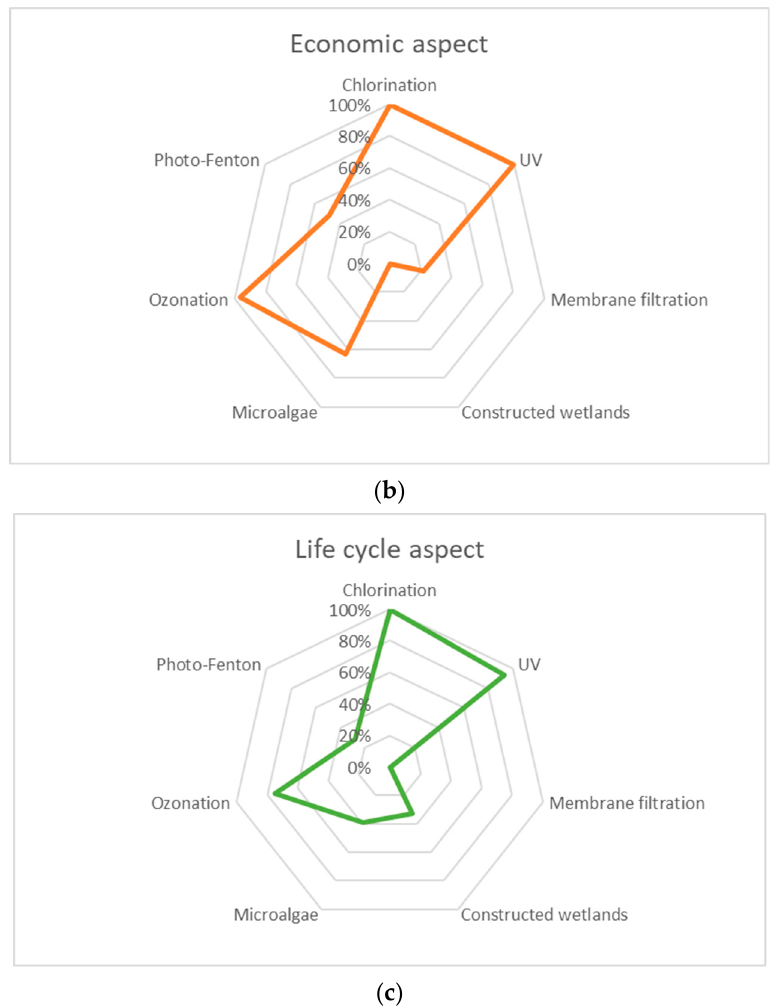
Figure 1. Normalized scores for the three aspects examined for each tertiary treatment method; ( a ) technical aspect, ( b ) economic aspect, ( c ) life cycle aspect